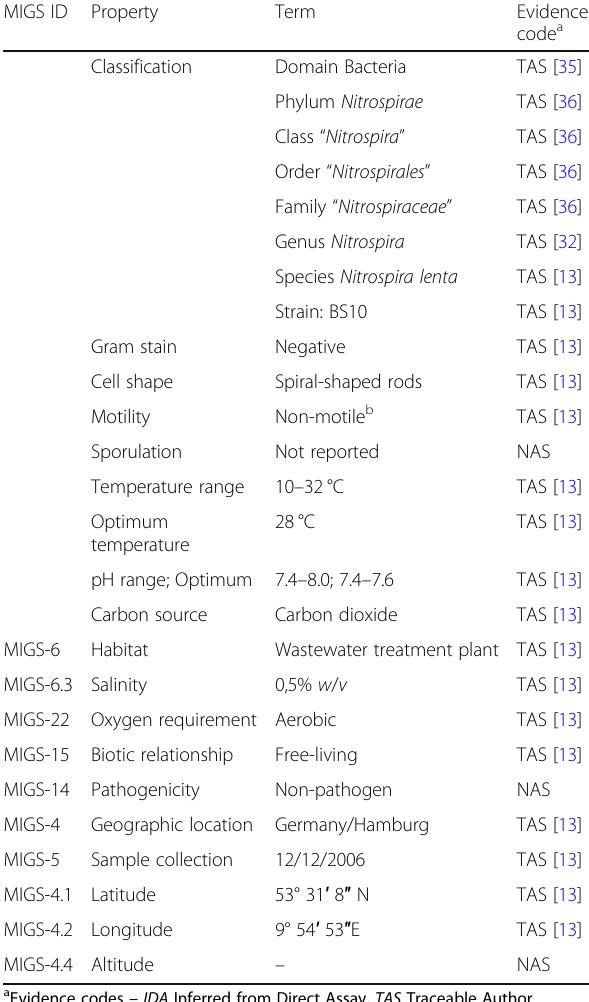
Table 1 Classification and general features of “ Nitrospira lenta ” strain BS10